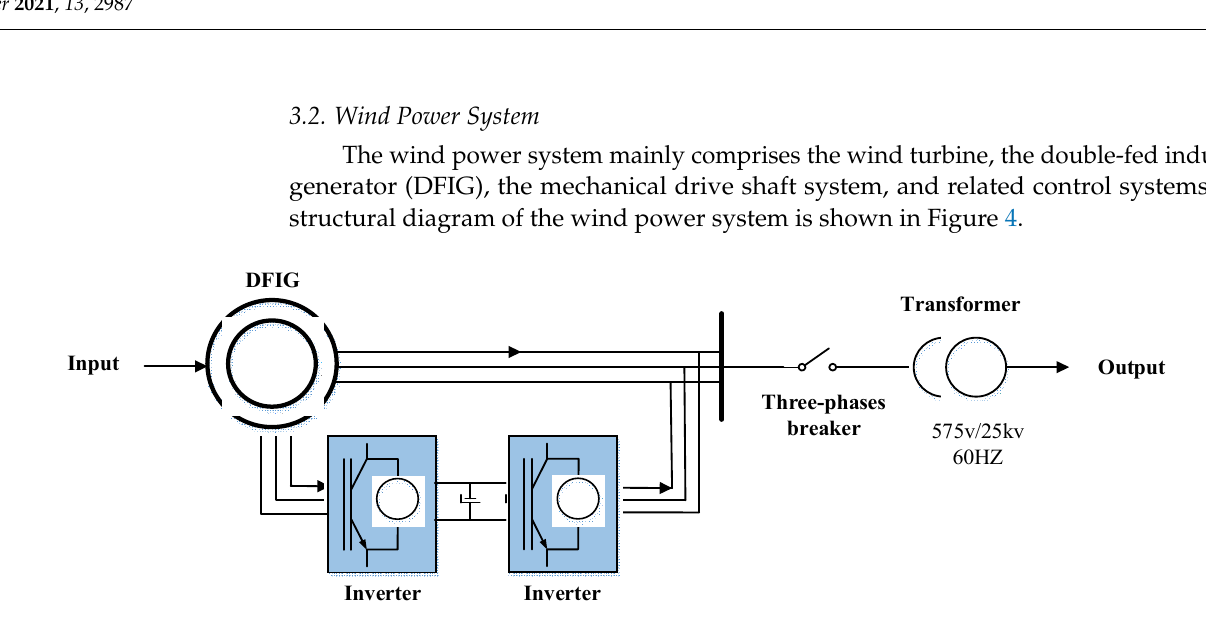
Figure 3. Block diagram of the hydropower generation system. dw , P ref , P e and P m represent the deviation of generator rotor speed, the reference power, the electrical power and the hydro-turbine output power, respectively. Vref , V d , V q , V stab and V f represent the reference voltage, the stator voltage in d -axis, the stator voltage in q -axis, the stable voltage and the field voltage of excitation system. i , i fd and Q eo represent the stator current, the field current, the reactive power.